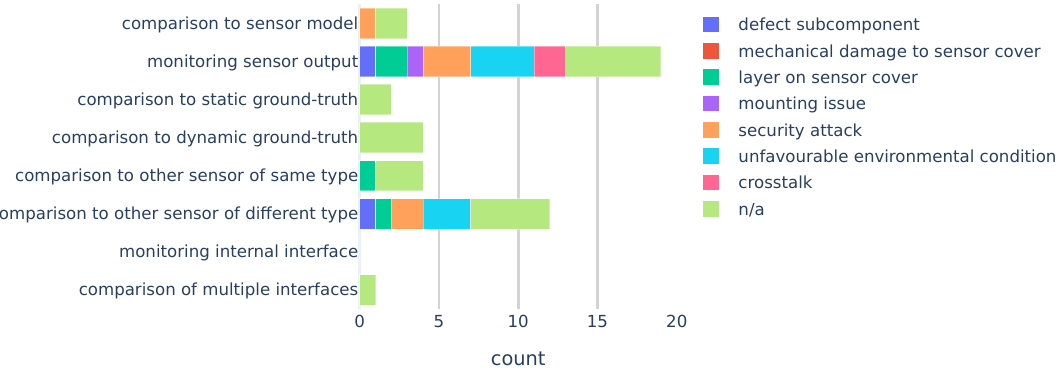
Figure 7. FDII classes count with colour coding according to the mentioned fault class in the publication. Some papers present fault detection methods without mentioning a specific fault, as indicated by the “n/a”